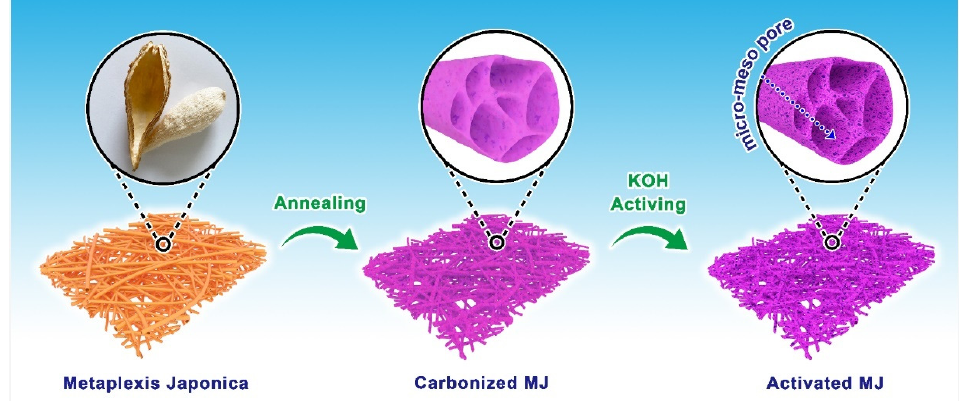
Figure 1. A conceptual diagram detailing the preparation process of MJ-biomass porous carbon. The morphology and microstructure of precursor were shown in Figure S1. Abun- dant fiber structures and pleated surfaces are captured in Figure S1a,b. SEM images and local magnification in Figure S1c–f show that the biomass generally has an original hollow fiber structure with a wall thickness of 1~2 μ m. After KOH activation (Figure 2a–c), some large pore structures were observed, but the original structure was not completely col- lapsed; instead, the initial shape is maintained due to the thick wall. The MJ − 5 SEM image at a lower magnification also shows that most of the activated carbon possess hollow fiber structures although it is not an intact structure and somewhere is broken or chipped. The zoom-in image for MJ − 5 reveals an impressive image with a hierarchical pore structure on the fiber wall in the range of 0–400 nm (Figure 2f). In contrast, MJ − 1 and MJ − 3 presented in Figure 2d,e possess fewer holes on the fiber surface. MJ biomass-derived porous carbon structure diagrams are presented in Figure 2g. MJ − 5 shows a hierarchical pore structure consisting of macropores, mesopores, and micropores. Among them, the macropores can act as an ion buffering reservoir; the mesopores, as fast transport channels, play a critical role in the ion diffusion, especially for the larger ion; the micropores can offer charge stor- age location [39]. Figure 2h schematically shows a more detailed structural explanation.